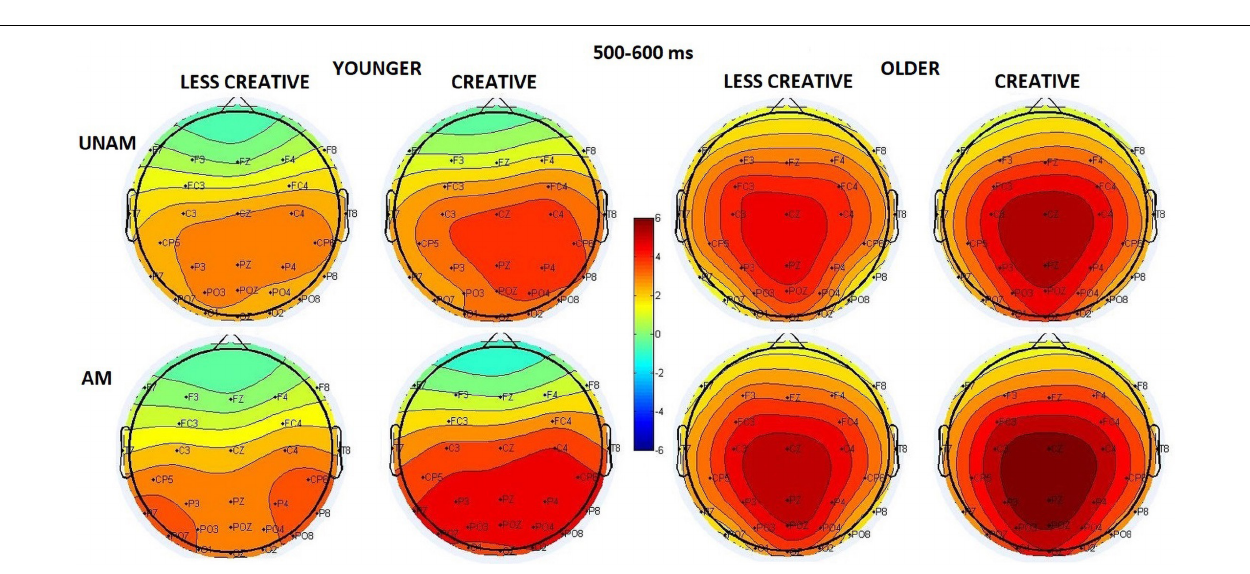
FIGURE 8 | Scalp distribution for the 500–600 ms range in the four groups (younger – less creative, younger – creative, older – less creative, older – creative) for unambiguous (top row) and ambiguous (bottom row)